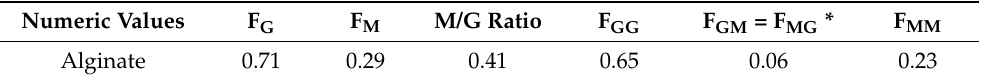
Table 3. Numerical values for the uronic acid composition, M/G ratio, and doublet frequencies of alginate extracted from C. sinuosa.